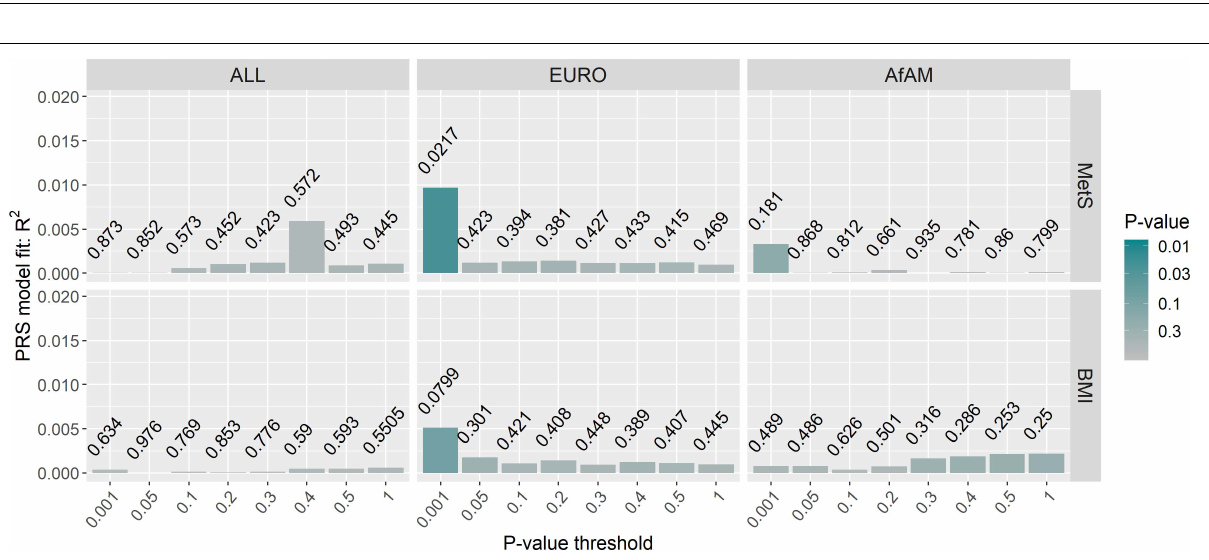
Frontiers in Neuroscience |